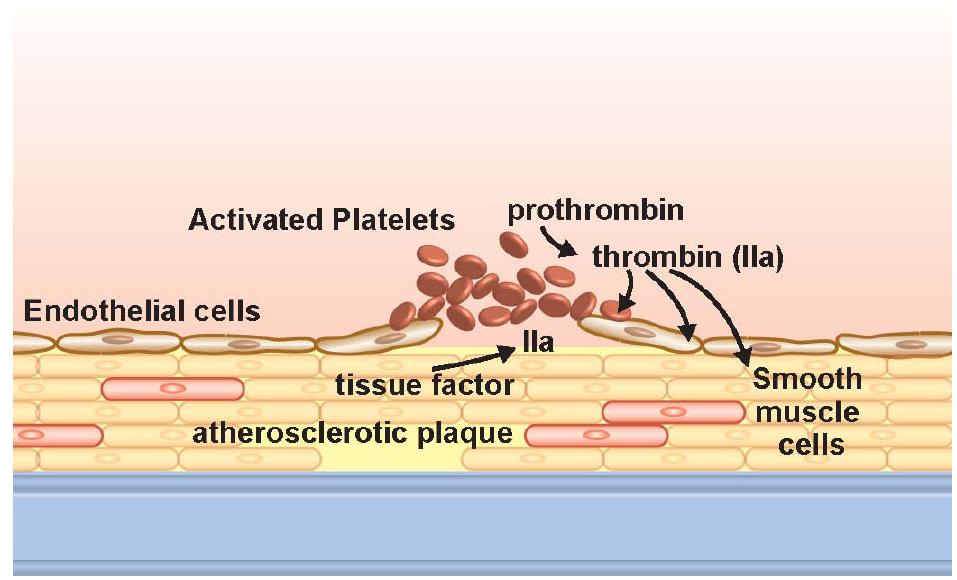
Figure 1. Platelet adherence to the endothelium occurs at the site of vascular injury, often in an area of atherosclerosis. Damage, erosion, or rupture of the endothelial surface, or an underlying atherosclerotic plaque exposes subendothelial matrix to which platelets adhere and are activated (see Figure 2). Tissue factor may also be present and result in the generation of thrombin (IIa). Additionally, thrombin can be generated along the surface of activated platelets or released microparticle (not depicted). Thrombin, in turn, can elicit effects on platelets, and endothelial or smooth muscle cells in the